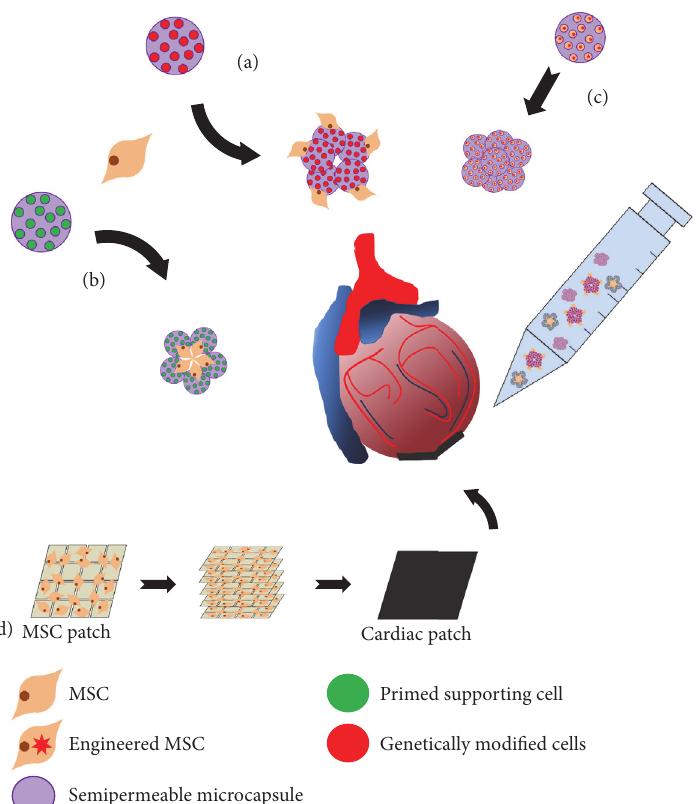
Figure 1: Therapeutic strategies of MSC-based tissue engineering. (a) Genetically modified MSCs are encapsulated into semipermeable microcapsules. This modified MSC secrete cytokine for homed stem cell. (b) Semipermeable microcapsules containing primed supporting cells.SecretedcytokinesfromprimedsupportingcellsenhanceMSCcellularfunction.(c)EngineeredMSCsencapsulatedintosemipermeable microcapsules. MSCs secreted recombinant hormone such as glucagon-like peptide 1. Each semipermeable microcapsule is transplanted into infracted region of heart. (d) MSCs seeded on biomaterial-based patch. Multilayered cells as a cardiac patch for myocardial